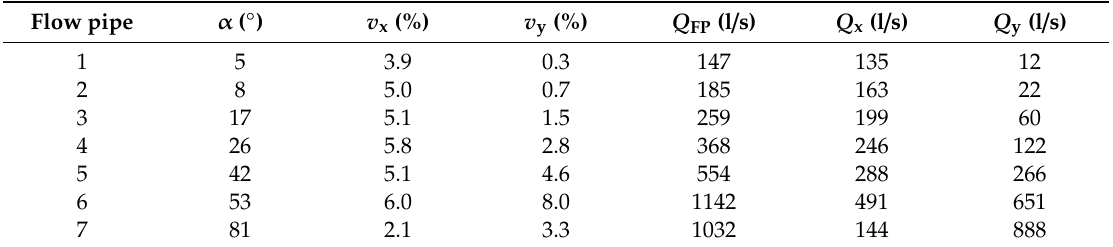
Table 2. The main results obtained by flow vectors analysis; α , slope angle of the flow vector; v x , horizontal velocity; v y , vertical velocity; Q FP, discharge of the flow pipe; Q x discharge of the horizontal component of the flow; Q y discharge of the vertical component of the